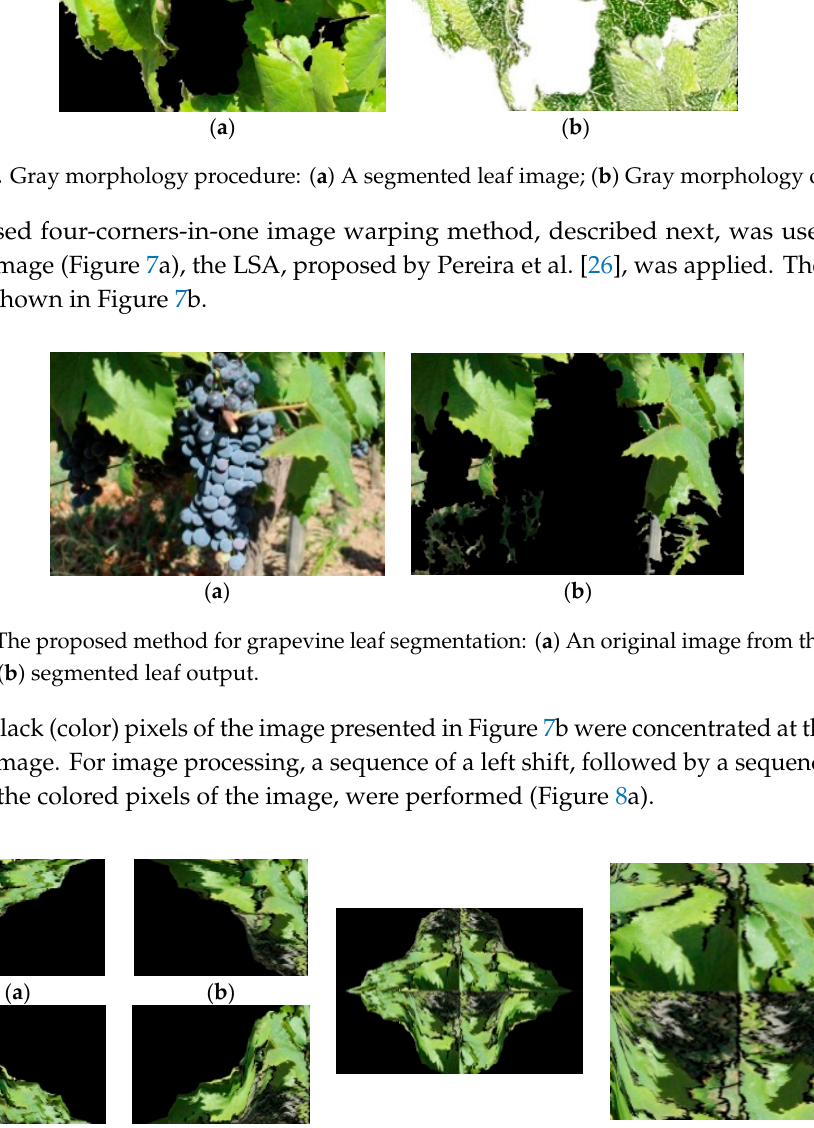
Figure 5. Canny edge detection operator: ( a ) Segmented leaf image; ( b ) Canny output result.